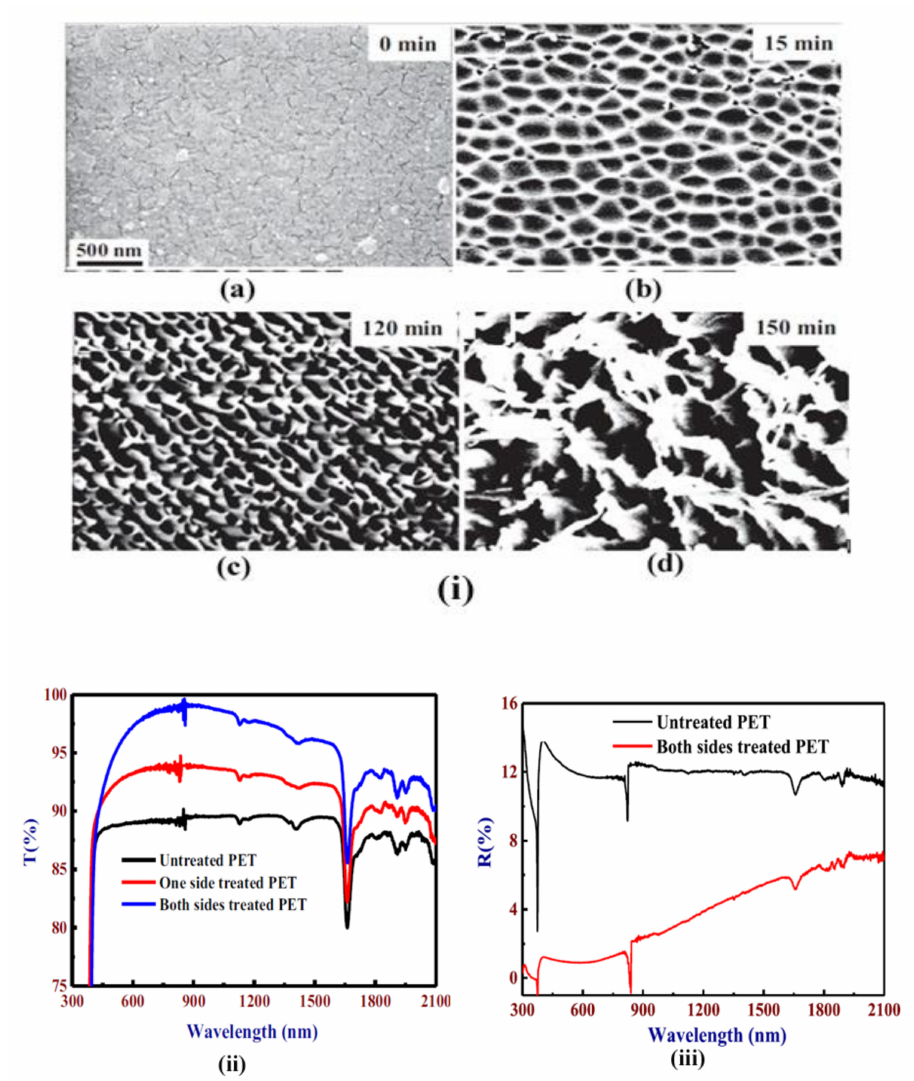
Figure 23. ( i ) FESEM micrographs of ( a ) untreated PET (0 min) ( b ) treated PET for 15 min ( c ) 120 min ( d ) 150 min; ( ii ) Transmittance spectra of untreated, one side treated and both sides treated PET. ( iii ) Variation of reflectance for untreated and both sides treated PET. Reprinted with permission [195]; 2016,